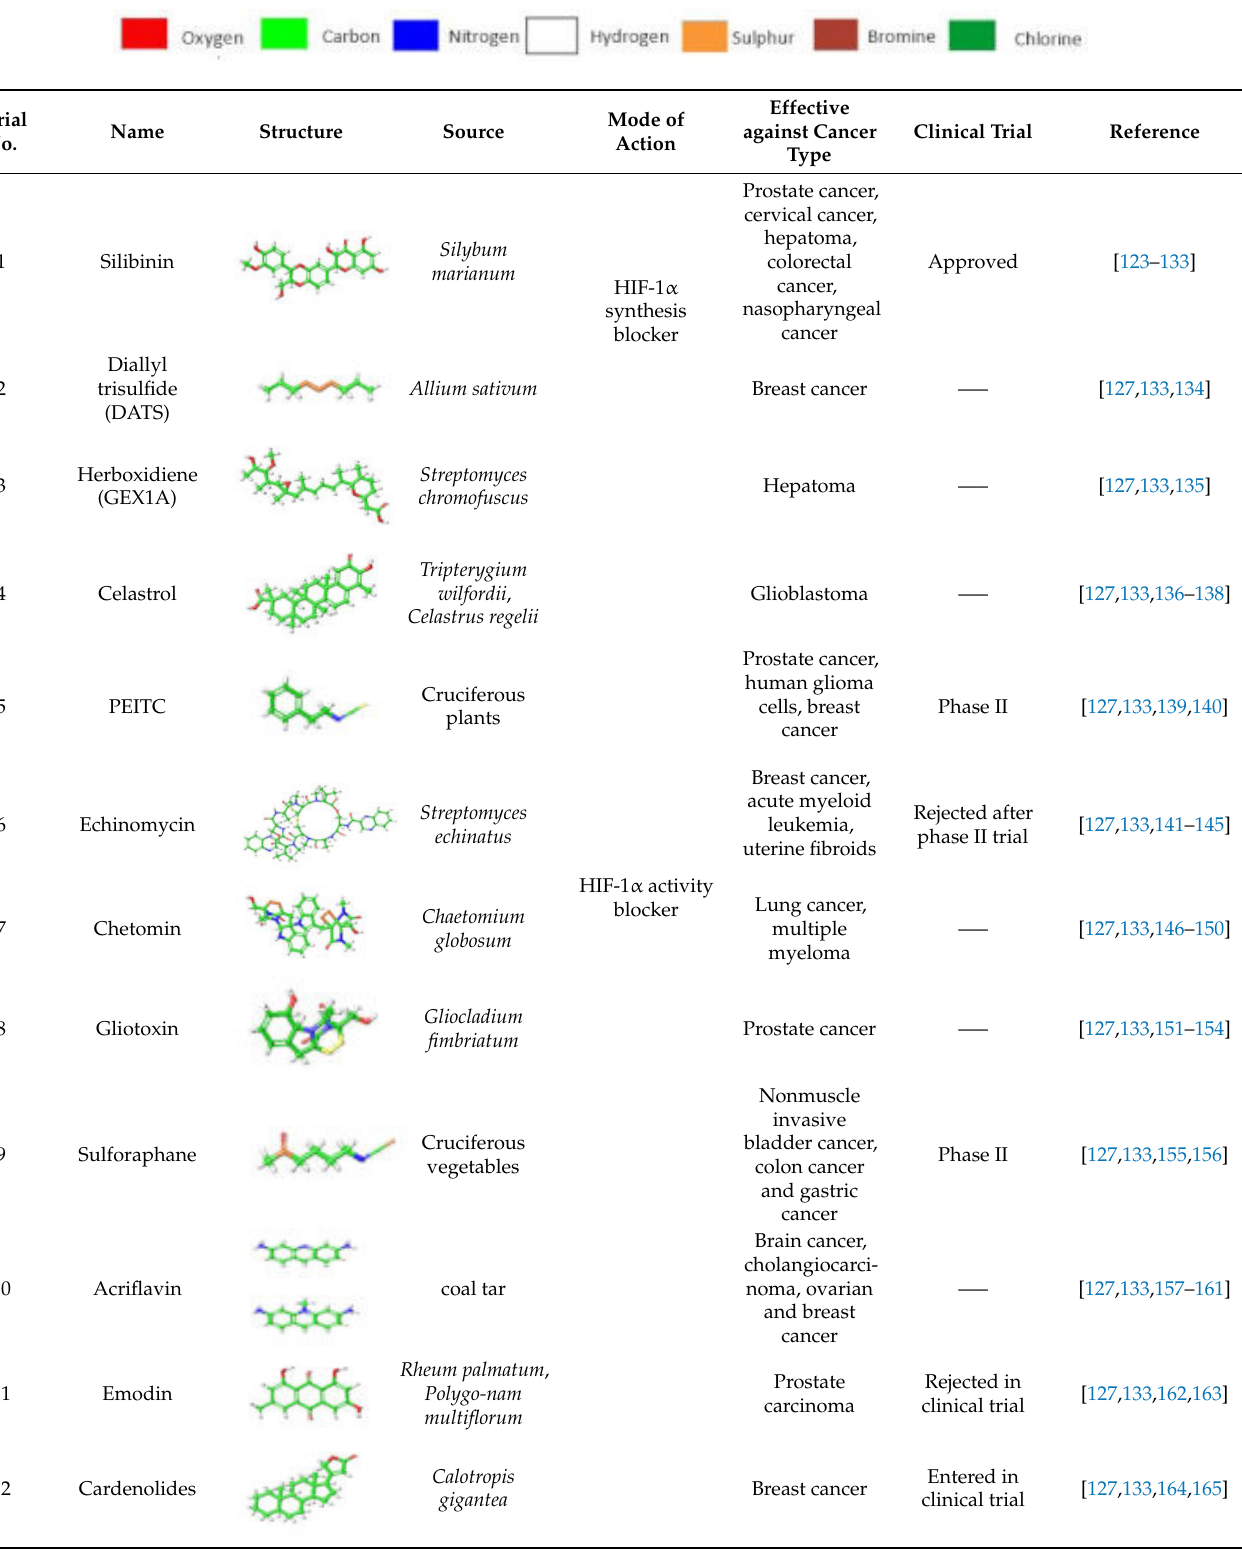
Table 1. List of various potential natural HIF-1 α inhibitors based on their mode of action in different